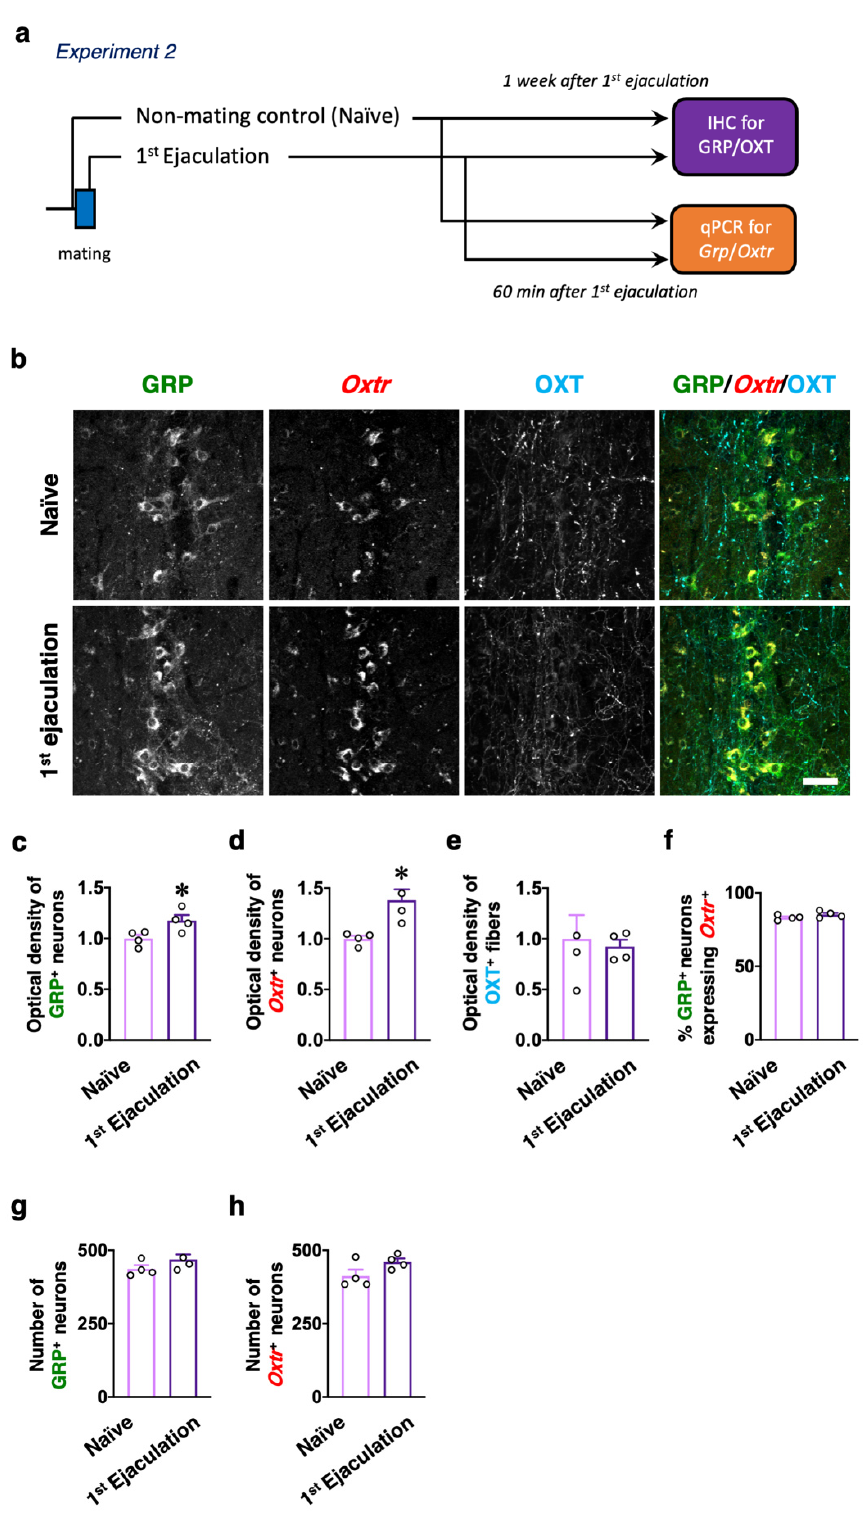
Figure 2. ( a ) Experimental paradigm of Experiment 2: effects of sexual experience on the dXL neuron system. ( b ) Immunohistochemistry for GRP and OXT in the upper lumbar spinal cord of Oxtr -YFP transgenic (Tg) male rats with or without sexual experience ( n = 4, respectively). GRP-immunoreactivity (green) and YFP signals ( Oxtr ) (red) were higher in 1st-Ejaculation Tg male rats than in Naïve Tg male rats. No difference was noted in the intensity of OXT-positive ( + ) fibers (Cyan). In this study, we detected the immunofluorescence of OXT-neurophysin as a marker for OXT neurons. Scale bar: 100 µm. ( c ) The intensity of GRP + neurons significantly increased in 1st-Ejaculation Tg male rats